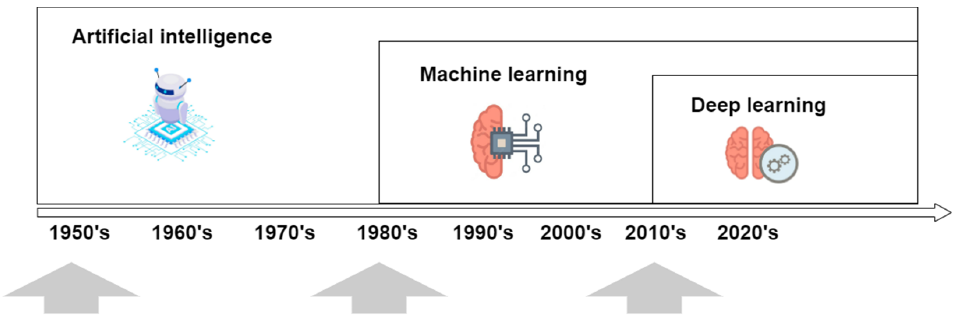
Figure 2. Artificial